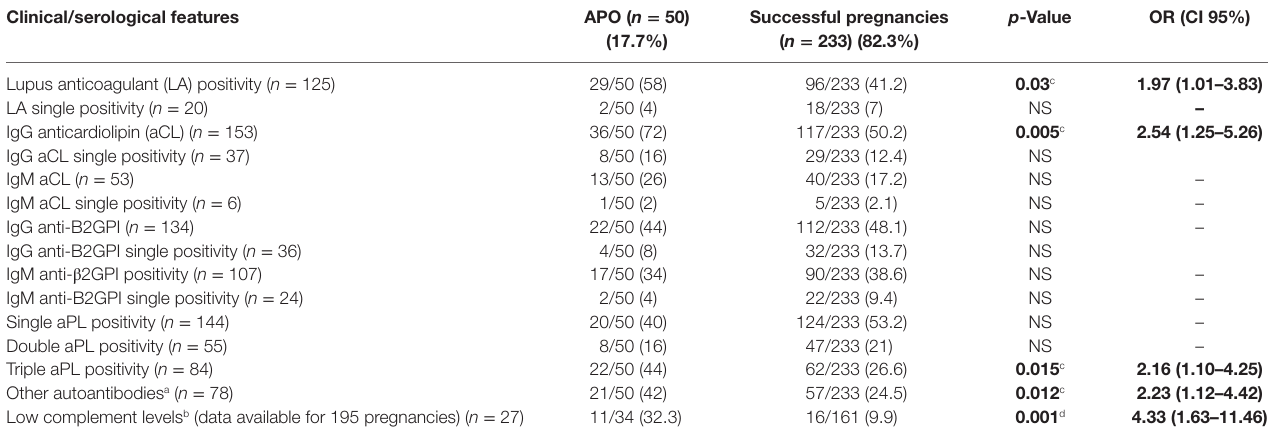
Table 5 | Univariate analysis of serological features in successful and adverse pregnancy outcome (APO) pregnancies. clinical/serological features